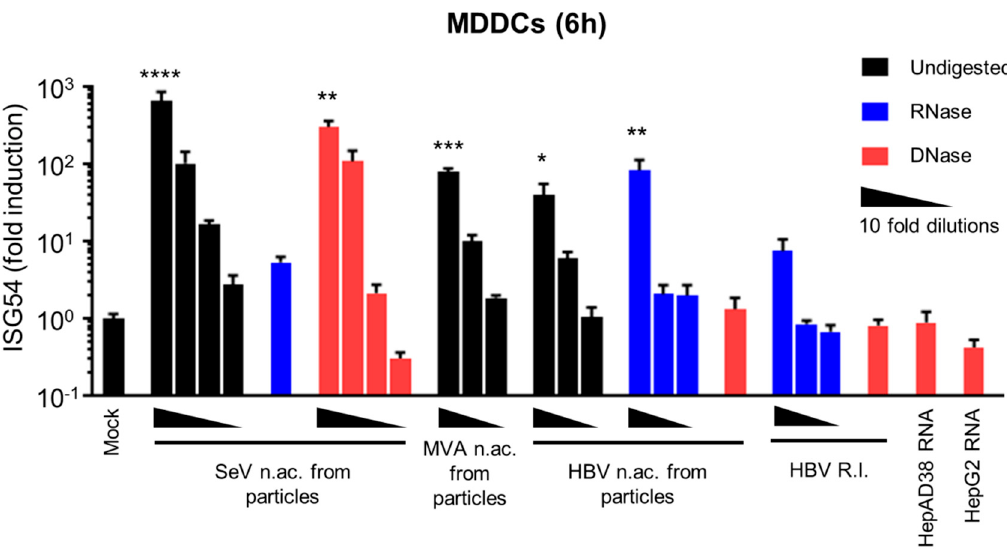
Figure 1. HBV DNAs but not RNAs are immunostimulatory. Total nucleic acids (n.ac.) were extracted from SeV, MVA-gfp or HBV particles. HBV DNA replication intermediates (HBV R.I.) were extracted from HepAD38 cytoplasm. Total RNAs were extracted from HepAD38 or HepG2 cells. When indicated, thenucleicacidsweredigestedwithRNAse(blue)orDNAse(red; blackbars: undigested). HumanMDDCs were transfected with 10-fold dilutions of the nucleic acids (quantified in Table 3). ISG54 mRNA level was quantified by RT-qPCR 6 h post-transfection. Average and SEM of three technical replicates of at least two donors are shown. Levels of significance over mock transfection: **** p < 0.0001, *** p < 0.001, ** p < 0.01 and * p < 0.05 (Kruskal–Wallis test with Dunn’s multiple comparisons